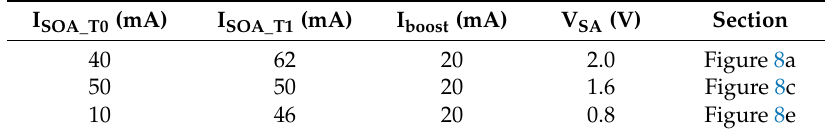
Figure 8. Optical and electrical spectra of the multi-section semiconductor laser diode. ( a ) Optical frequency comb with a modal spacing of 0.2 nm (25 GHz); ( b ) RF electrical tone at 25 GHz repetition rate for passive (red) and hybrid (blue) regimes, the achieved electrical linewidth are ~350 KHz and less than 1 Hz, respectively; ( c ) optical spectrum with lasing modes separated each 0.8 nm (100 GHz); ( d ) RF electrical tone at 100 GHz repetition rate in passive regime condition; and ( e ) optical spectrum of the two tones emission with a frequency spacing of 1.1372 THz, with 25 dB suppression ratio of the adjacent optical modes. Table 1. Bias conditions to achieve optical frequency combs with repetition rates of 25 and 100